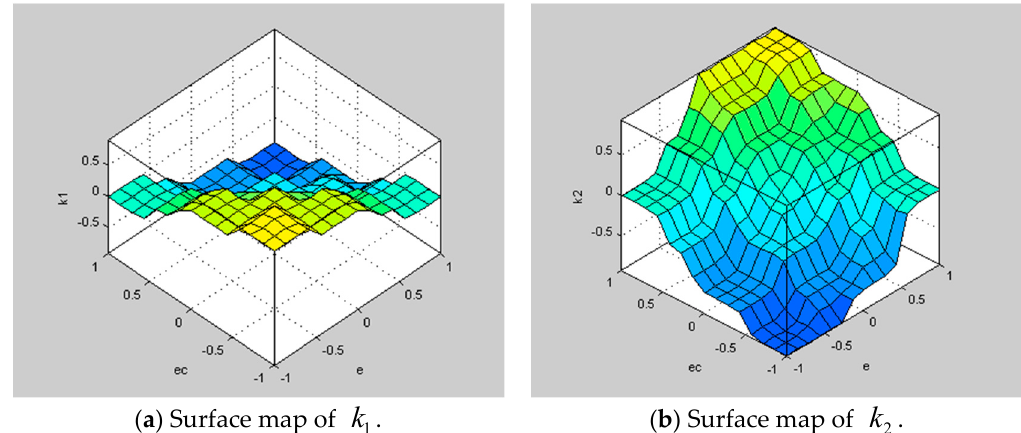
k . Figure 9. Surface map of k 1 and k 2 2